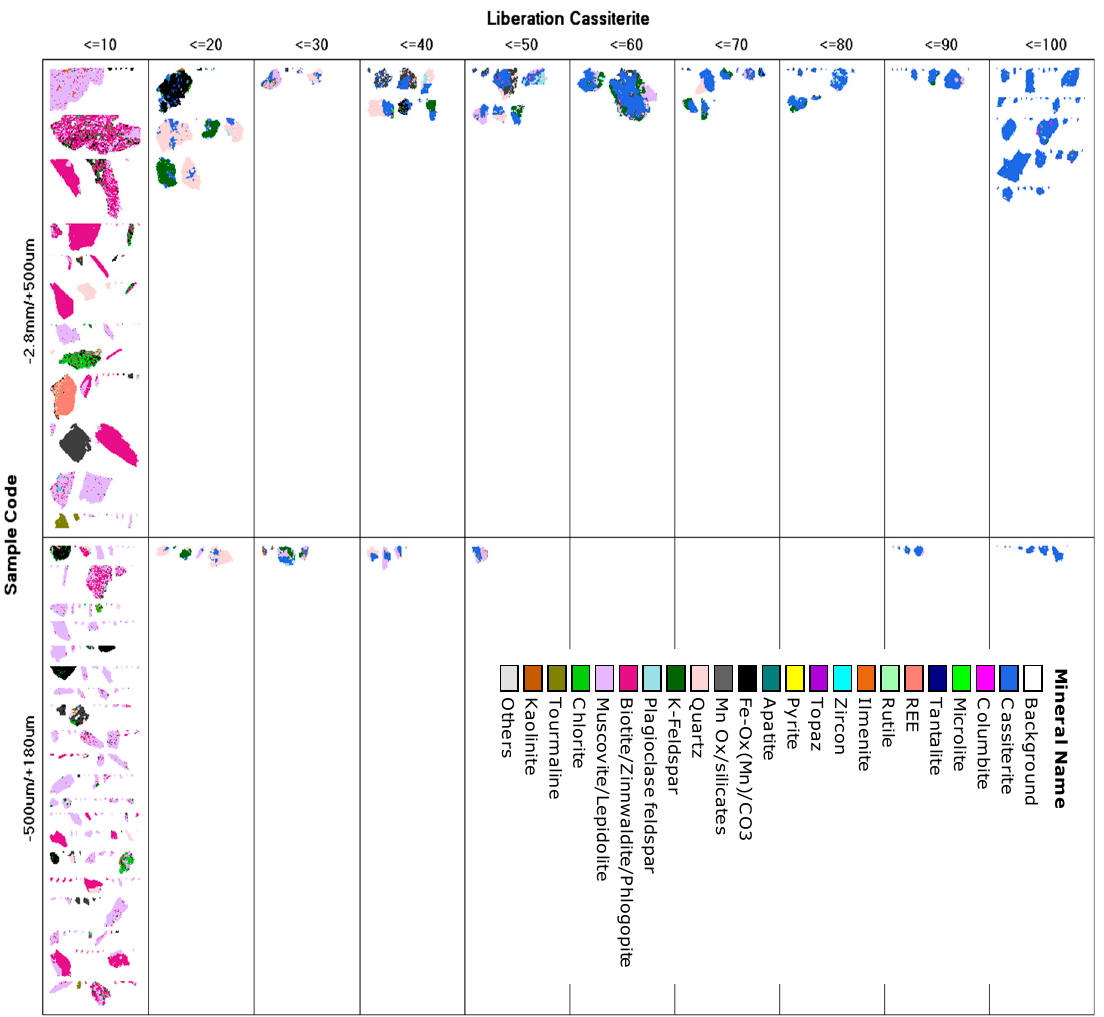
Figure 7. Image Grids of cassiterite liberation in the two HLS products.